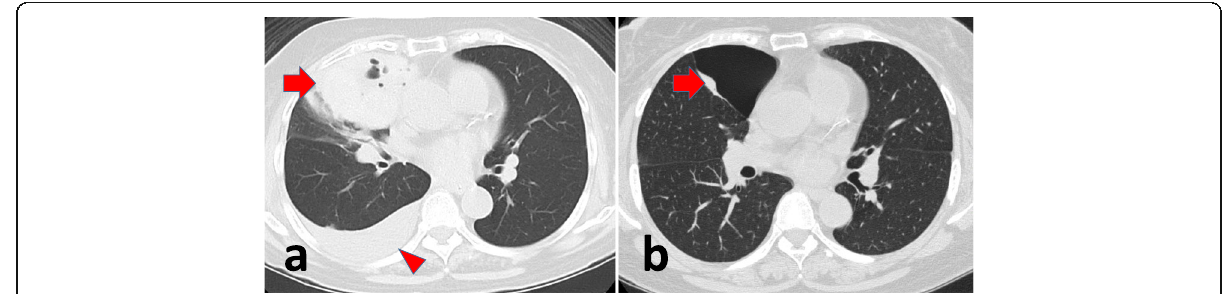
Fig. 2 a A chest CT on admission revealed an air-fluid mass (arrow) adjacent to the right upper and middle lobe with a pleural effusion (arrowhead). b A CT scan obtained 15 years prior revealed a cyst(arrow)at the corresponding